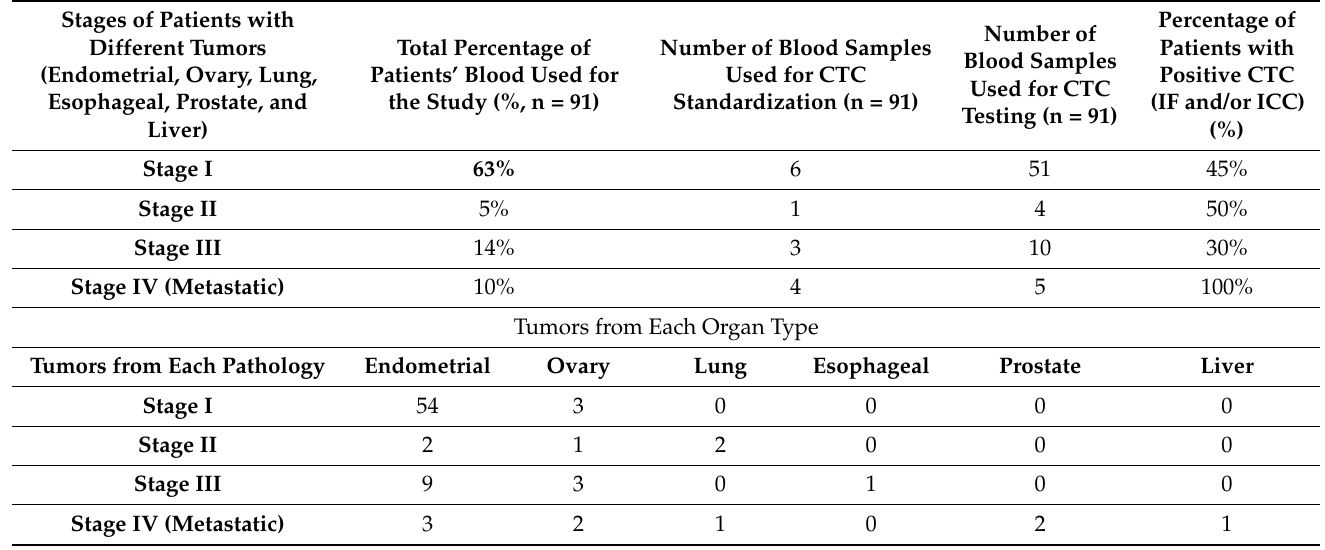
Table 1. Stage-wise distribution of patients’ blood samples used for the standardization and testing of CTCs, with tumors from each pathology.